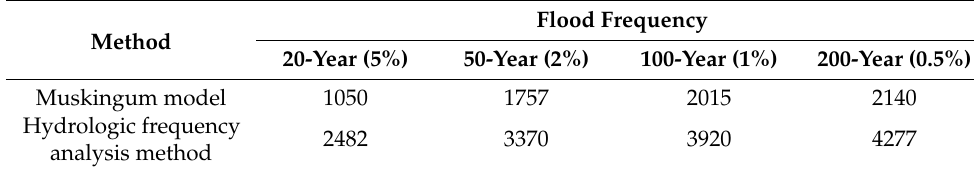
Table 1. Result validation of Guanjiatun Hydrological Station m 3 /s.